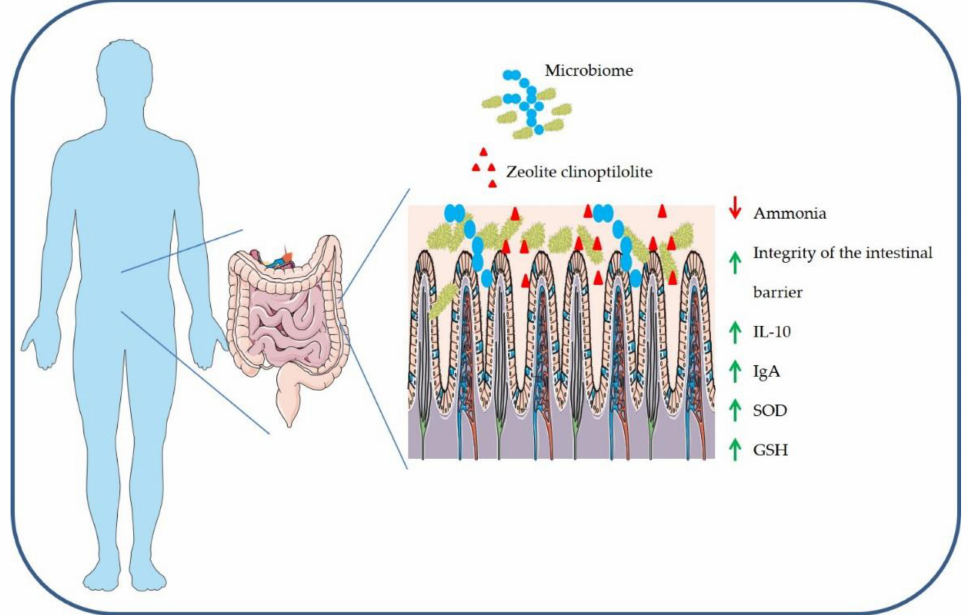
Figure 3. Zeolite clinoptilolite (ZC) reduces ammonia concentration and improves the integrity of the intestinal barrier. Furthermore, ZC acts on intestinal lymphoid tissues with a positive impact on the intestinal ecosystem and boosting the immune system. ZC avails metal ions, present within its structure, as cofactors for the activation of antioxidant